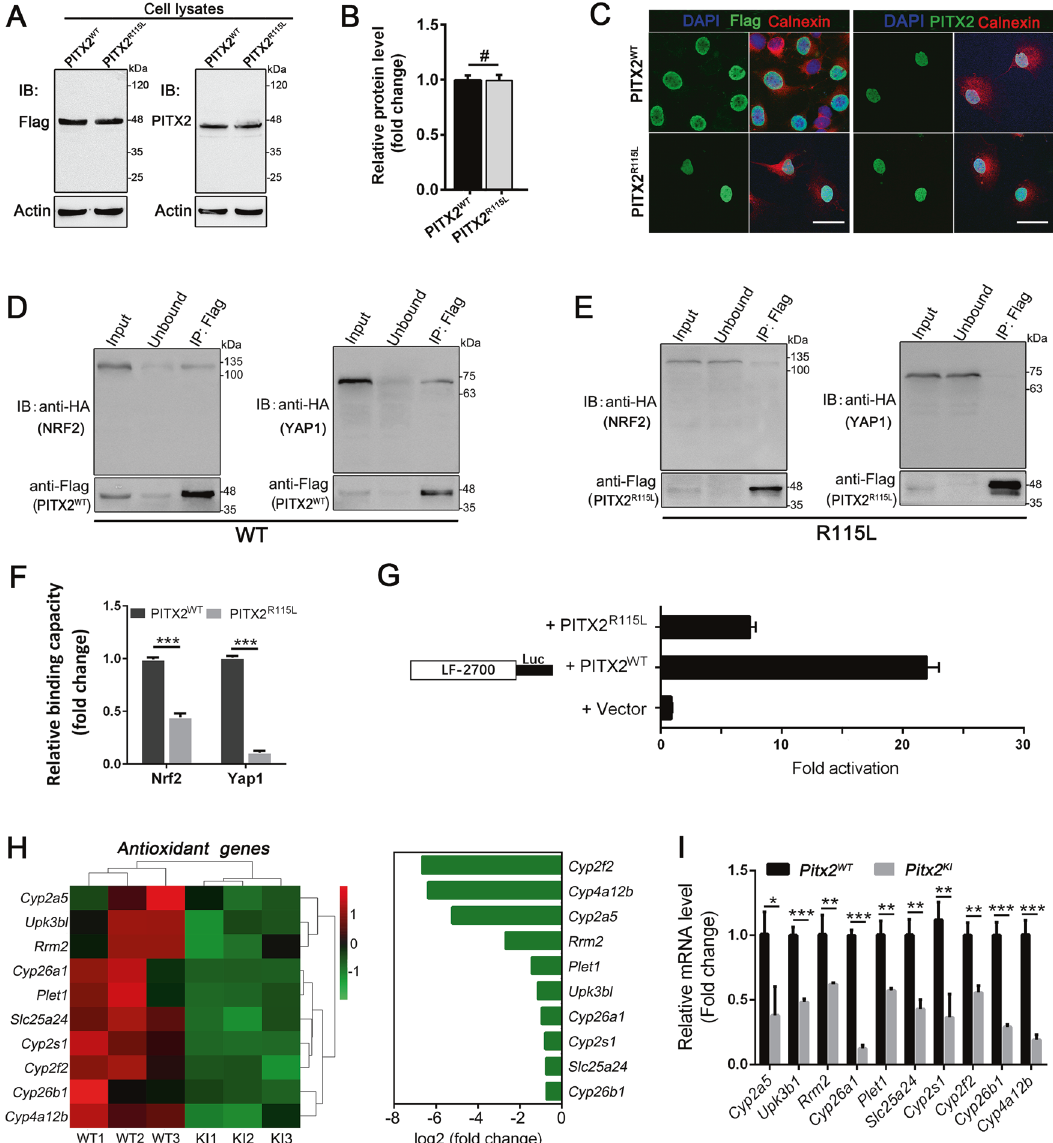
Fig. 5 Analysis of the biochemical and molecular changes observed in Pitx2 KI mutant mice. A Expression of WT and mutant PITX2 proteins in 293T cells. The pCMV-Pitx2 WT and pCMV-Pitx2 R115L expression plasmids were transfected into 293T cells. Western blot analysis showed mutant PITX2 protein had the same abundance as WT. Antibody of Flag-tag was used to verify the speci fi city of PITX2 antibody. β -actin was used as the loading control. B Quantitative comparison of the WT and mutant PITX2 protein levels in transfected cells ( n = 6 per cohort). C Subcellular localization of WT and mutant PITX2 proteins in COS7 cells. Immunocytochemistry study using anti-PITX2 antibody indicated that both WT and mutant PITX2 proteins were localized in the nucleus. D 293T cells were co-transfected with the indicated constructs. Flag immunoprecipitation, and blotting with anti-HA con fi rmed physical interaction. PITX WT -Flag was immunoprecipitated and the amount of co- precipitated NRF2-HA (left panels) or YAP1-HA (right panels) was determined by immunoblotting, shown are representative immunoblots. E PITX2 R115L -Flag was immunoprecipitated and the amount of co-precipitated NRF2-HA (left panels) or YAP1-HA (right panels) was determined by immunoblotting, shown are representative immunoblots. F Quanti fi cation of immunoblots reveals the PITX2 p. R115L mutation decreases its interaction with NRF2 and YAP1 compared to WT ( n = 4 in each group). G The transcriptional activity of WT and mutant PITX2 was detected with a luciferase reporter in transient transfections of 293T cells. All luciferase activities are normalized to β -galactosidase activity and shown as mean-fold activation compared with the vector. Five independent replicas were performed. The mean LEF-1 promoter luciferase activity with PITX2 expression was about 200,000 light units per 15 μ g protein, and the β -galactosidase activity was about 65,000 light units per 15 μ g protein. H RNA-seq results showing that several antioxidant-related genes are downregulated in mutant retinas. I RT-qPCR veri fi ed the RNA-seq results for the indicated genes ( n = 12). * P < 0.05; ** P < 0.01; *** P < 0.001. #, no signi fi cant difference. The data are represented as mean ± SEM. Retinal cryosections stained with dihydroethidium (DHE) enzymes superoxide dismutase (SOD) and glutathione peroxidase (Fig. 6D) showed increased DHE reaction in n mutant retinas. (GSH-Px) and increased malondialdehyde (MDA) content were Quanti fi cation of fl uorescence intensity revealed a signi fi cant observed in mutant retinas (Fig. 6A – C), suggesting compromised increase in superoxide production in mutant mice, compared to antioxidant capacity and peroxidation in mutant retinas.